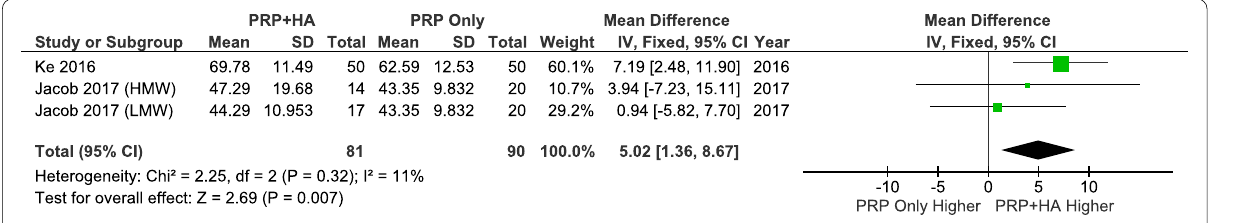
HA and PRP at 6 months after +